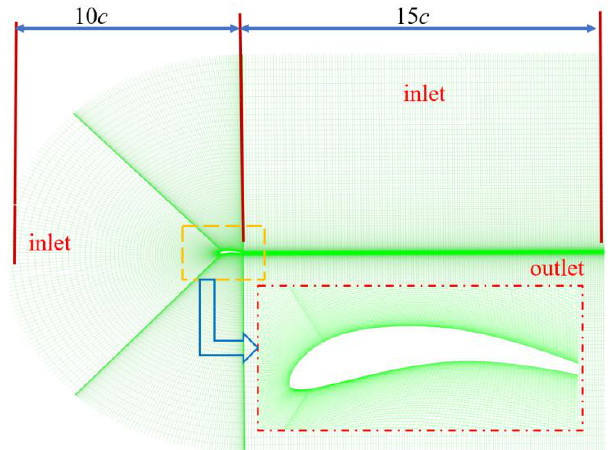
Figure 6. Computational domain meshing.